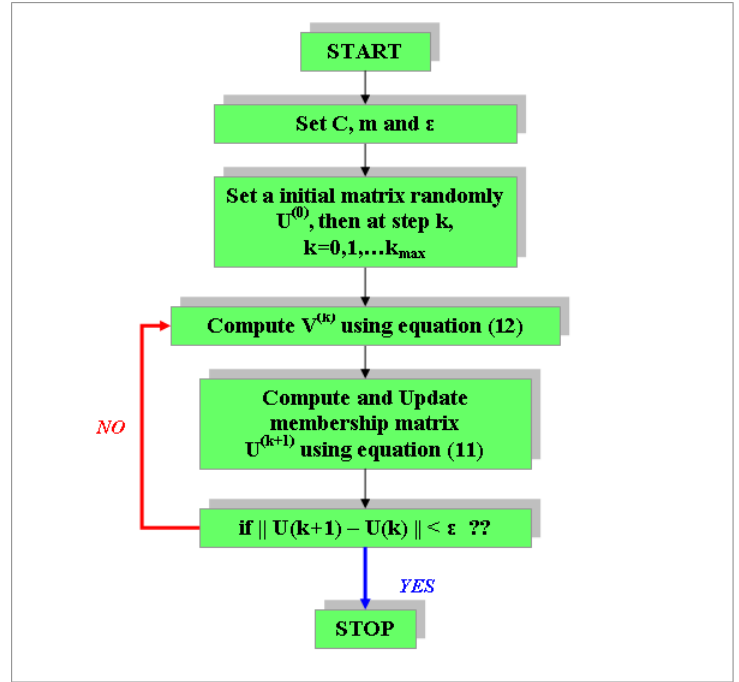
Figure 4. Fuzzy-C-means algorithm